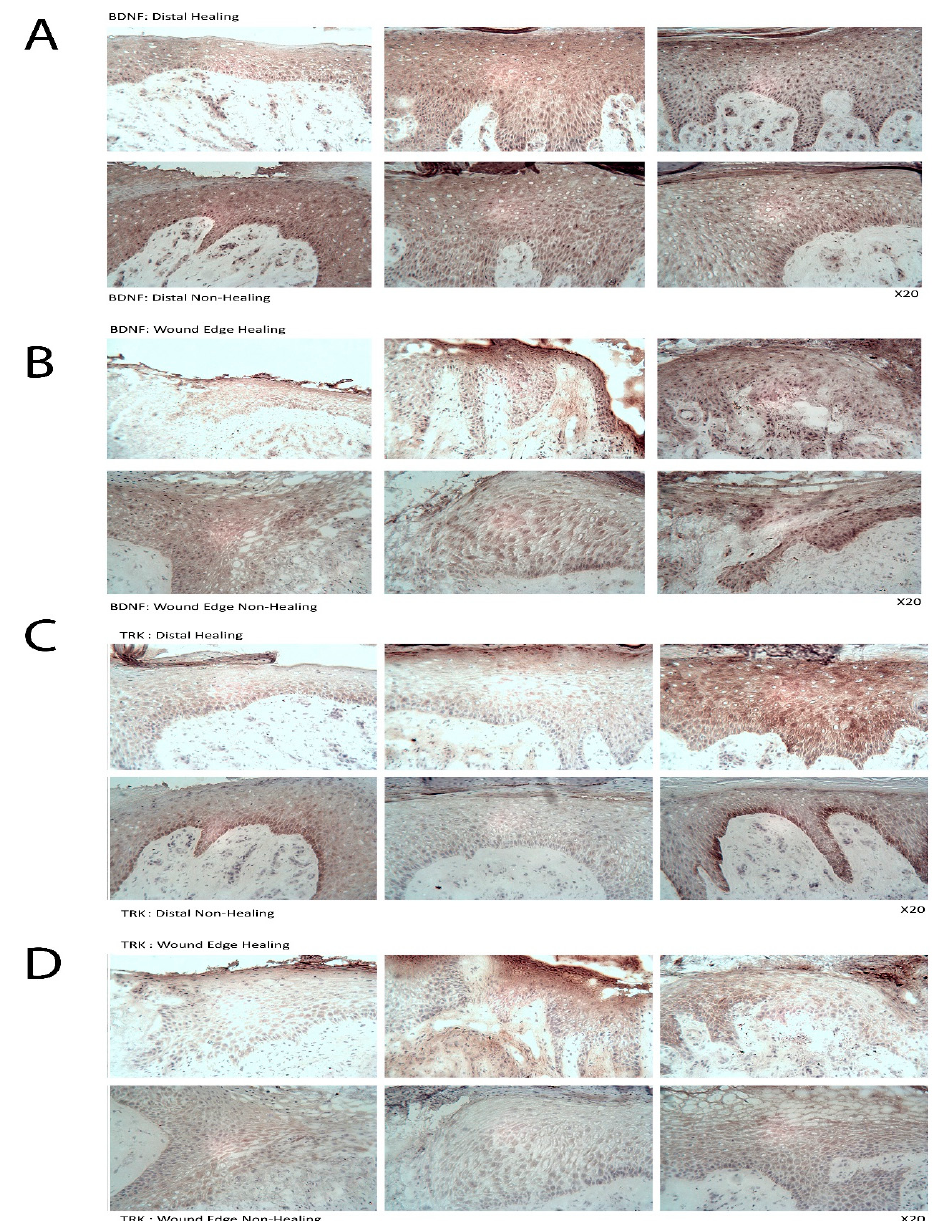
Figure 8. BDNF and TrkB expression in human chronic wound tissues. IHC of BDNF protein expression in healing and non-healing chronic wound tissues at distal ( A ) and wound-edge ( B ) locations. IHC of TrkB at distal ( C ) and wound-edge ( D ) locations. Arrows indicate areas of high-intensity staining. Two representative images of each group are shown; ×20 magnification was used.